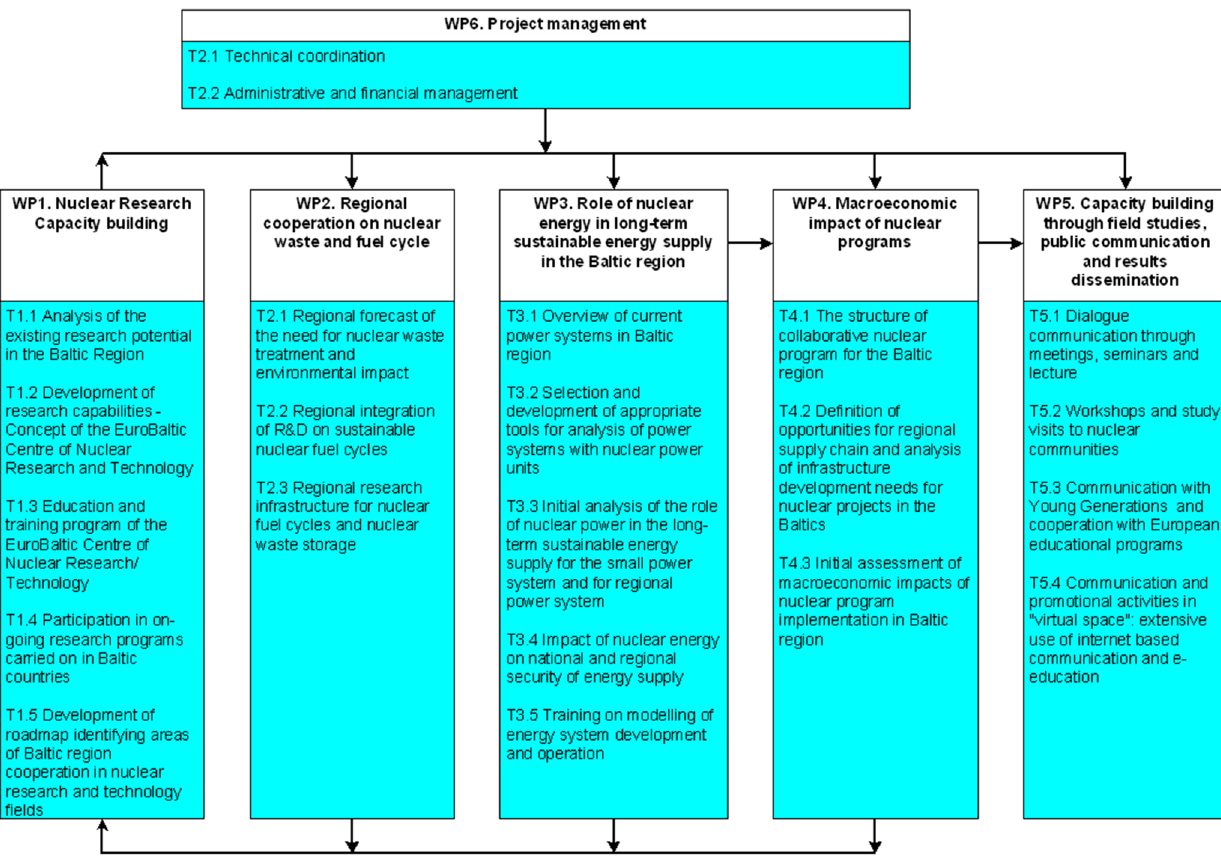
Fig. 3. Functional sketch of the BRILLIANT